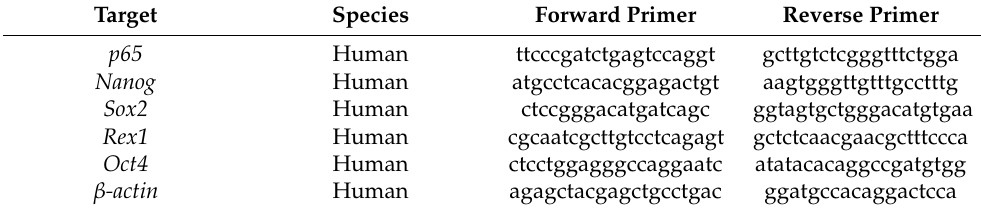
Table A3. List of